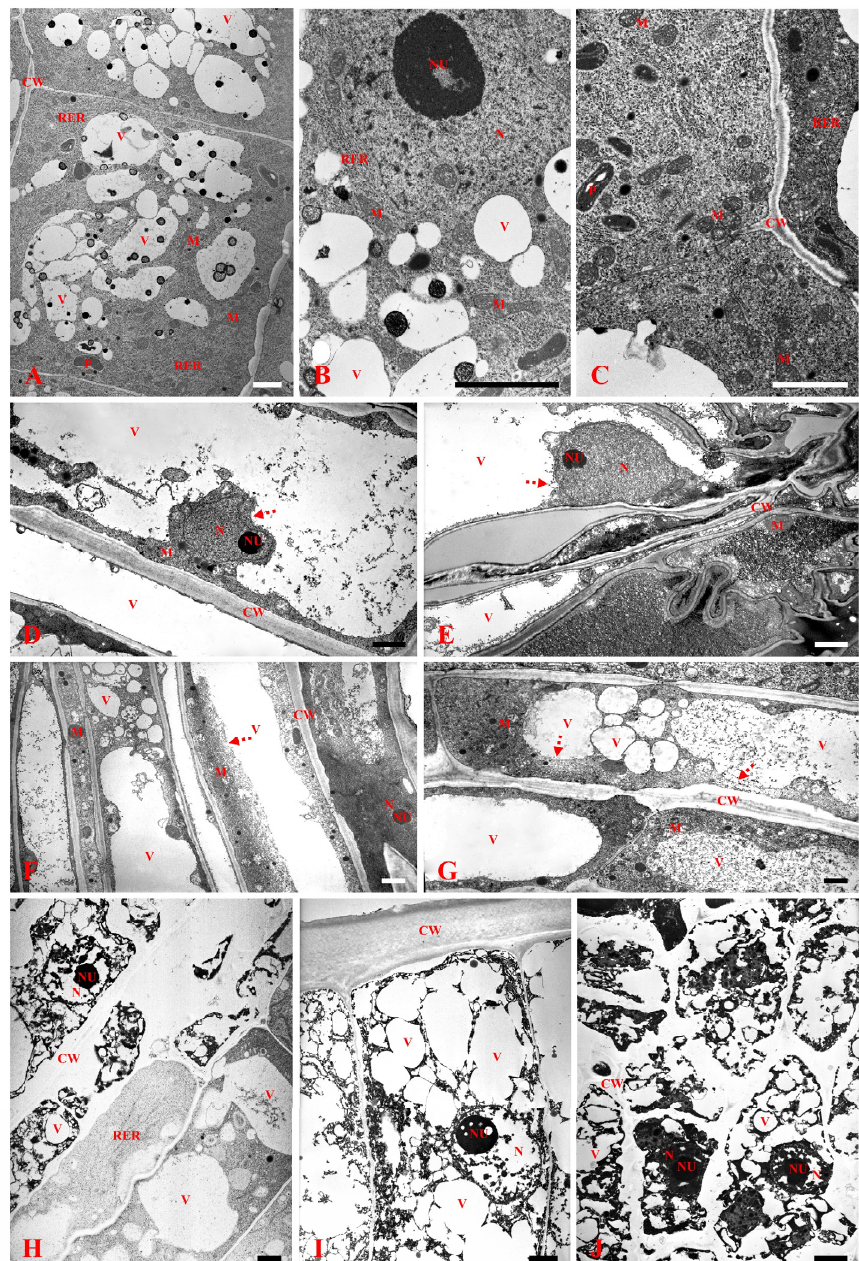
Figure 3. The ultrastructure of roots cells in the control ( A – C ) and treated with 250 µM ( D , E ), 500 µM ( F , G ). and 750 µM ( H – J ) of 3,4-DHP. Abbreviations: CW: cell wall; M: mitochondria; N: